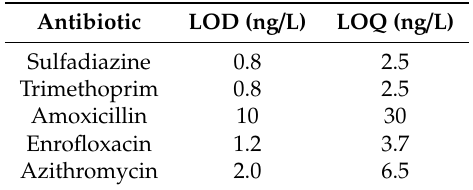
Table 2. Limits of detection and quantification of selected antibiotics.